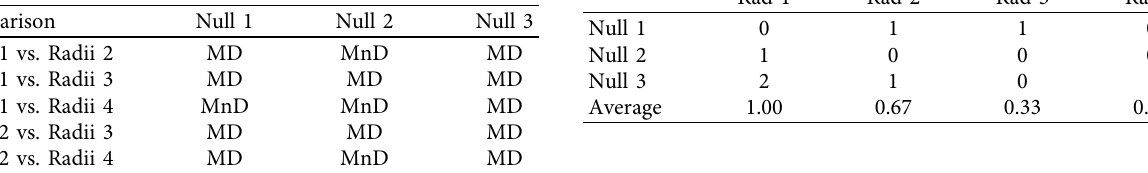
Table 21: Average power in the desired and all undesired directions corresponding to null steering at cluster radii 1, 2, 3, and 4 (wavelength normalized). SD denotes standard deviation. Rad. Desired dir.